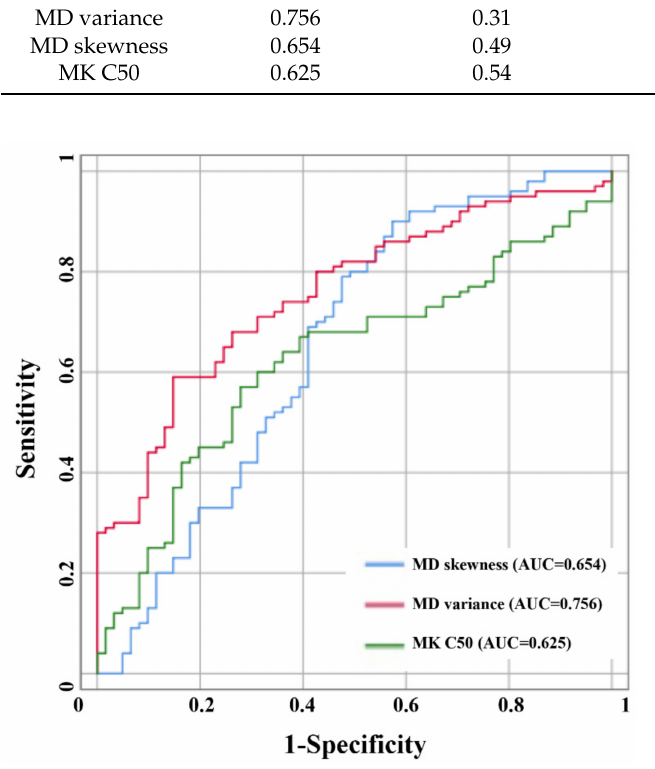
Figure 2. ROC curves of different DKI parameters for glioma grading. MD variance achieved the higher AUC (0.756), MD skewness and MK C50 showed lower values with AUCs of 0.654 and 0.625,